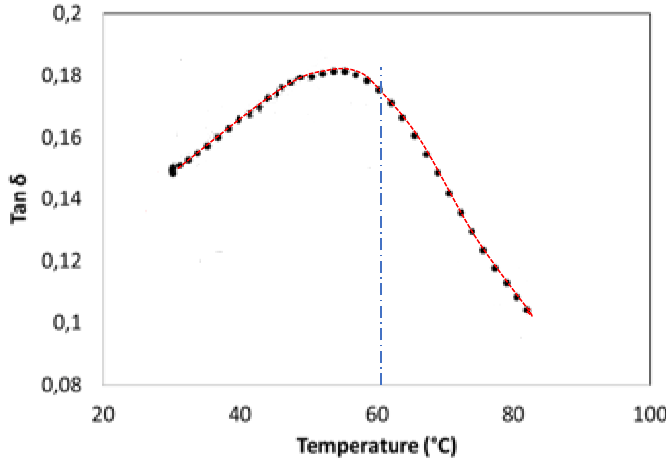
Figure 23. Obtained loss factor evolution versus temperature curve concerning CF-PA6.